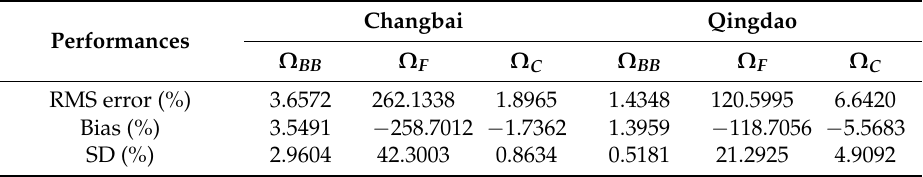
Table 13. The performances of FR estimators under the condition of joint errors.